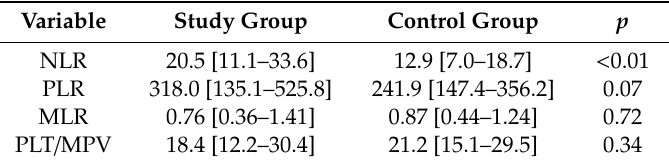
Table 3. Investigated haemogram-based indices.